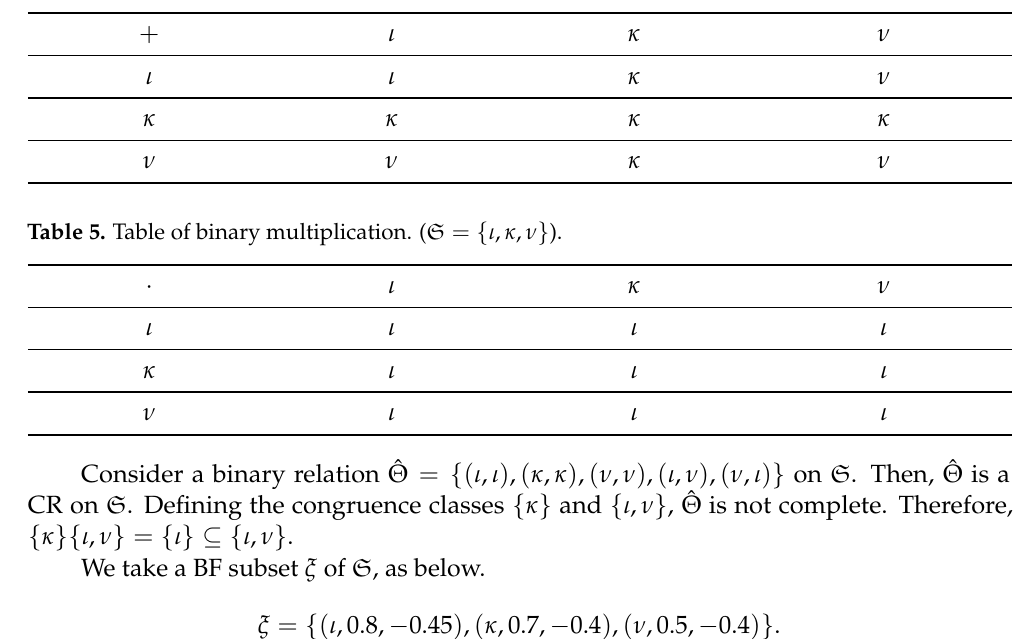
Table 4. Table of binary addition. ( S = { ι , κ , ν } ).